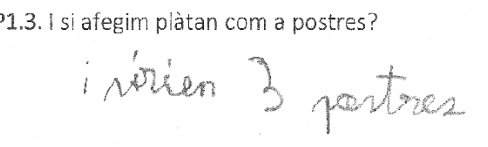
Table 7. Degree-strategy frequencies of Q3 and Q4.